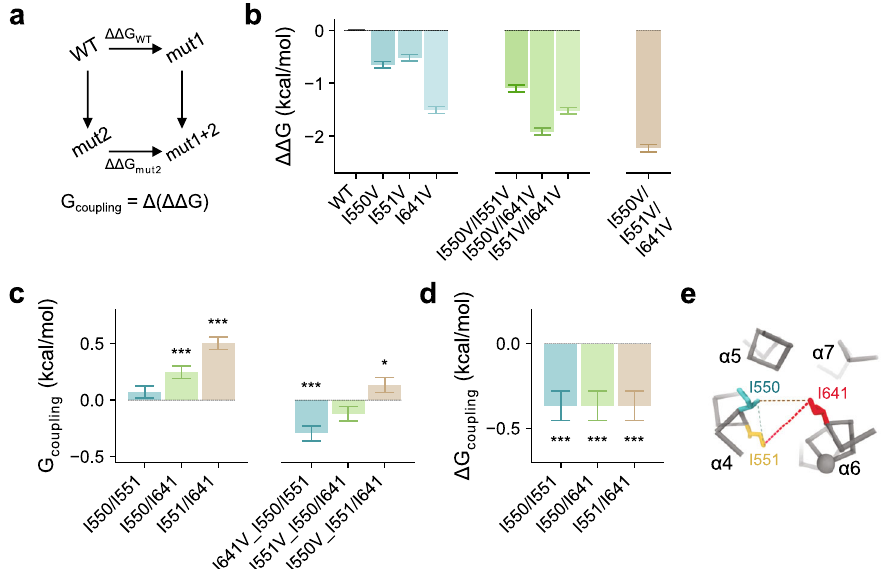
Fig. 5 Functional coupling within the triadic gate. a Schematic illustration of mutant cycle analysis. b ΔΔ G of the displayed mutants calculated by fi tting their concentration-response relations to an MWC-type gating model (Eqs. 4 – 6, 9, and 11 – 12). Bars indicate ΔΔ G calculated from the best- fi t values of the averaged data shown in Supplementary Fig. 7c. Errors correspond to 95% con fi dence intervals. c Coupling energy ( G coupling or ΔΔΔ G ) measured in double- mutant cycles in the background of WT (left) or indicated mutants (right). Bars indicate the values calculated from the best- fi t values shown in b using Eq. 13. d Change in coupling energy ( Δ G coupling or ΔΔΔΔ G) between the cycles displayed in c . Bars indicate the values calculated from the values shown in c using Eq. 14. e C α representation of the inner pore entrance viewed from the extracellular side. Dashed lines depict functional coupling between the displayed residues with a thickness approximately corresponding to the respective coupling energies shown in c , left. c , d Errors are standard errors. Asterisks indicate signi fi cant deviation from zero in a two-sided one-sample t -test (from left to right, c *** p = 2e − 5; *** p = 2e − 16; *** p = 2e − 5; * p = 0.043; d *** p = 3e − 5 for each